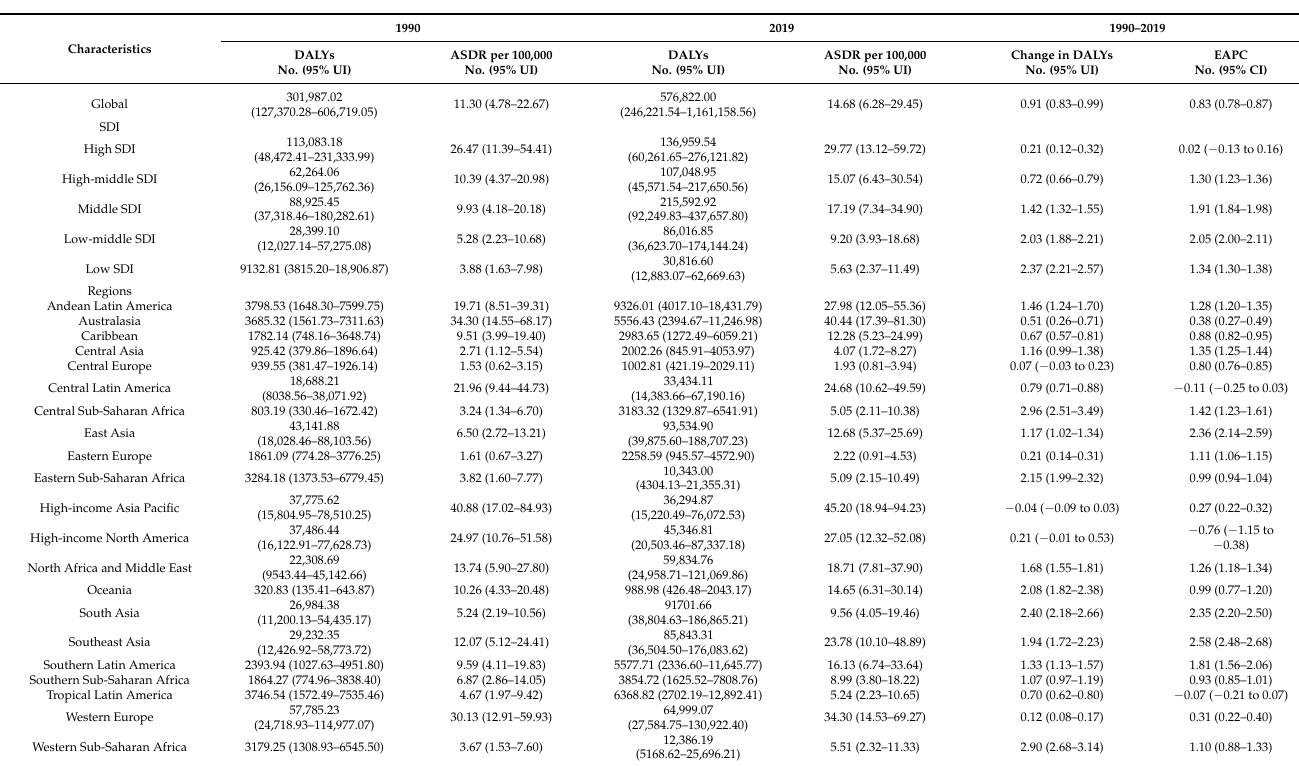
Table 2. The DALYs and ASDR of PCOS at the regional level and its temporal trends from 1990 to